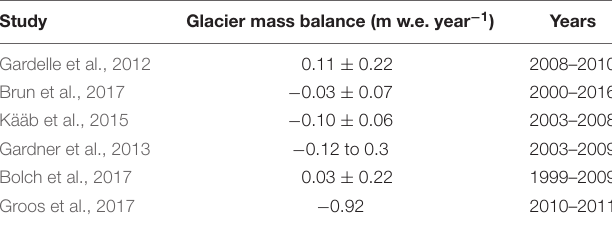
TABLE 2 | Overview of selected mass balance studies in the Karakoram.